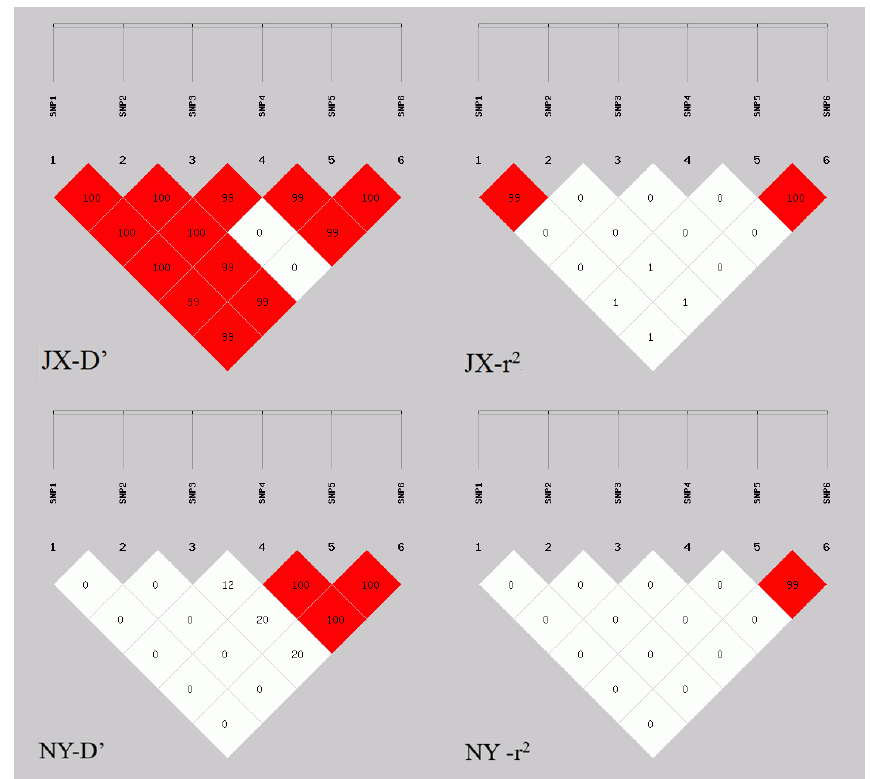
Figure 2. Linkage disequilibrium of Nanog gene polymorphisms in Jiaxian and Nanyang cattle. White squares show weak linkage and red squares show strong linkage.